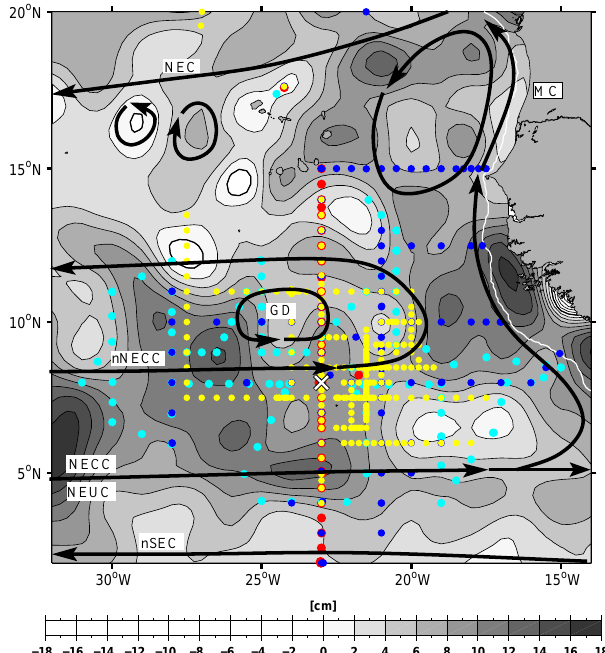
Figure 1. Aviso sea level height anomaly (in cm) for 25 Novem- ber 2009; cyclonic features are shown in bright color, anticy- clonic ones in dark grey. The CTD stations of R/V Merian cruise MSM10/1 in November–December 2008 (yellow dots), of R/V Me- teor cruise M80/1 in November 2009 (red dots), of cruise M80/2 in December 2009 (cyan dots) and of R/V Meteor cruise M83/1 in October–November 2010 (blue dots) are included. The white line off Africa marks the 200m depth contour. The white cross with a black frame at ∼ 8 ◦ N, 23 ◦ W marks the location of the tracer re- lease. Some upper ocean current bands based on earlier schematics (e.g., Mittelstaedt, 1983; Stramma and Schott, 1999; Stramma et al., 2008b; Peña-Izquierdo et al., 2012; Brandt et al., 2015) are shown as solid black lines. For current names please refer to the text. Cy- clonic as well as anticyclonic eddies are indicated in a location with corresponding sea level height